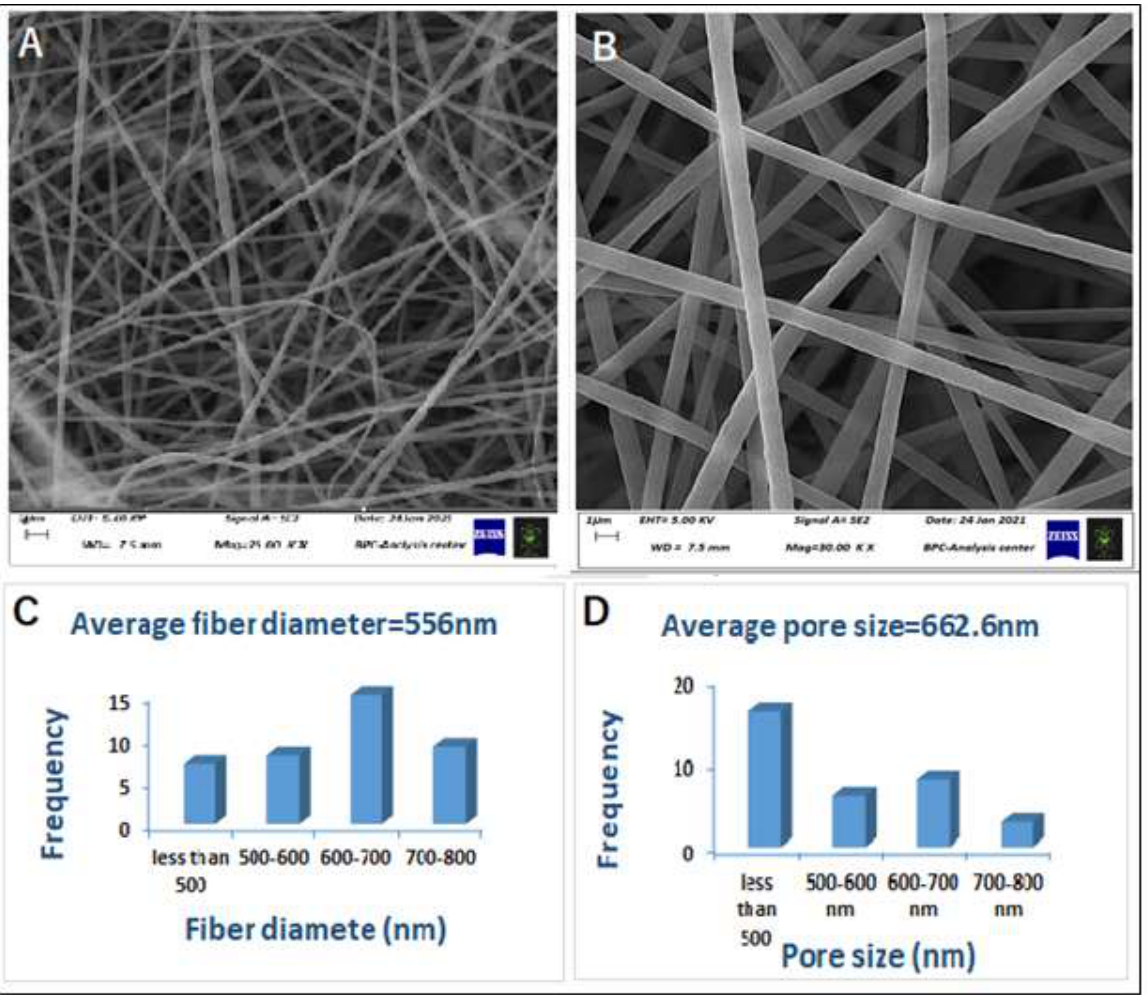
Figure 9: FE-SEM results of the synthesized PAN (15wt.%) nanofibers A) at low magnifications, and B) at high magnifications C) Average fiber diameter D) Average pore